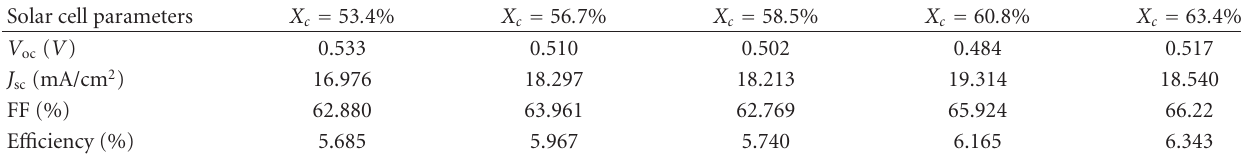
Table 1: Performance of each μ c-Si:H thin film solar cell with di ff erent crystallinity X c (%) in the intrinsic layer.